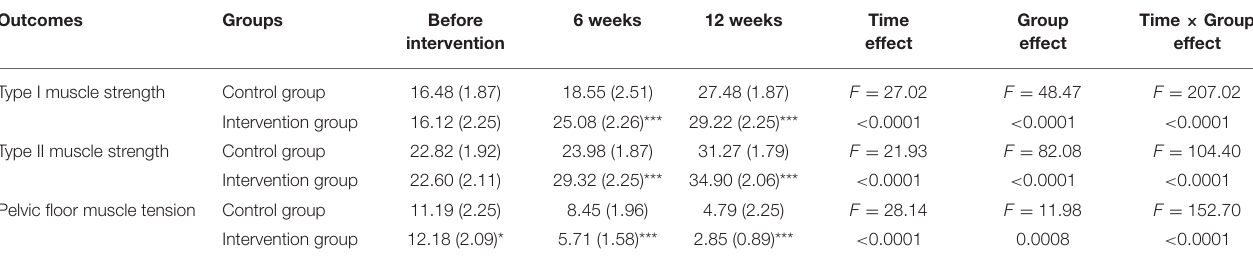
TABLE 3 | Outcomes associated with pelvic floor muscle function.